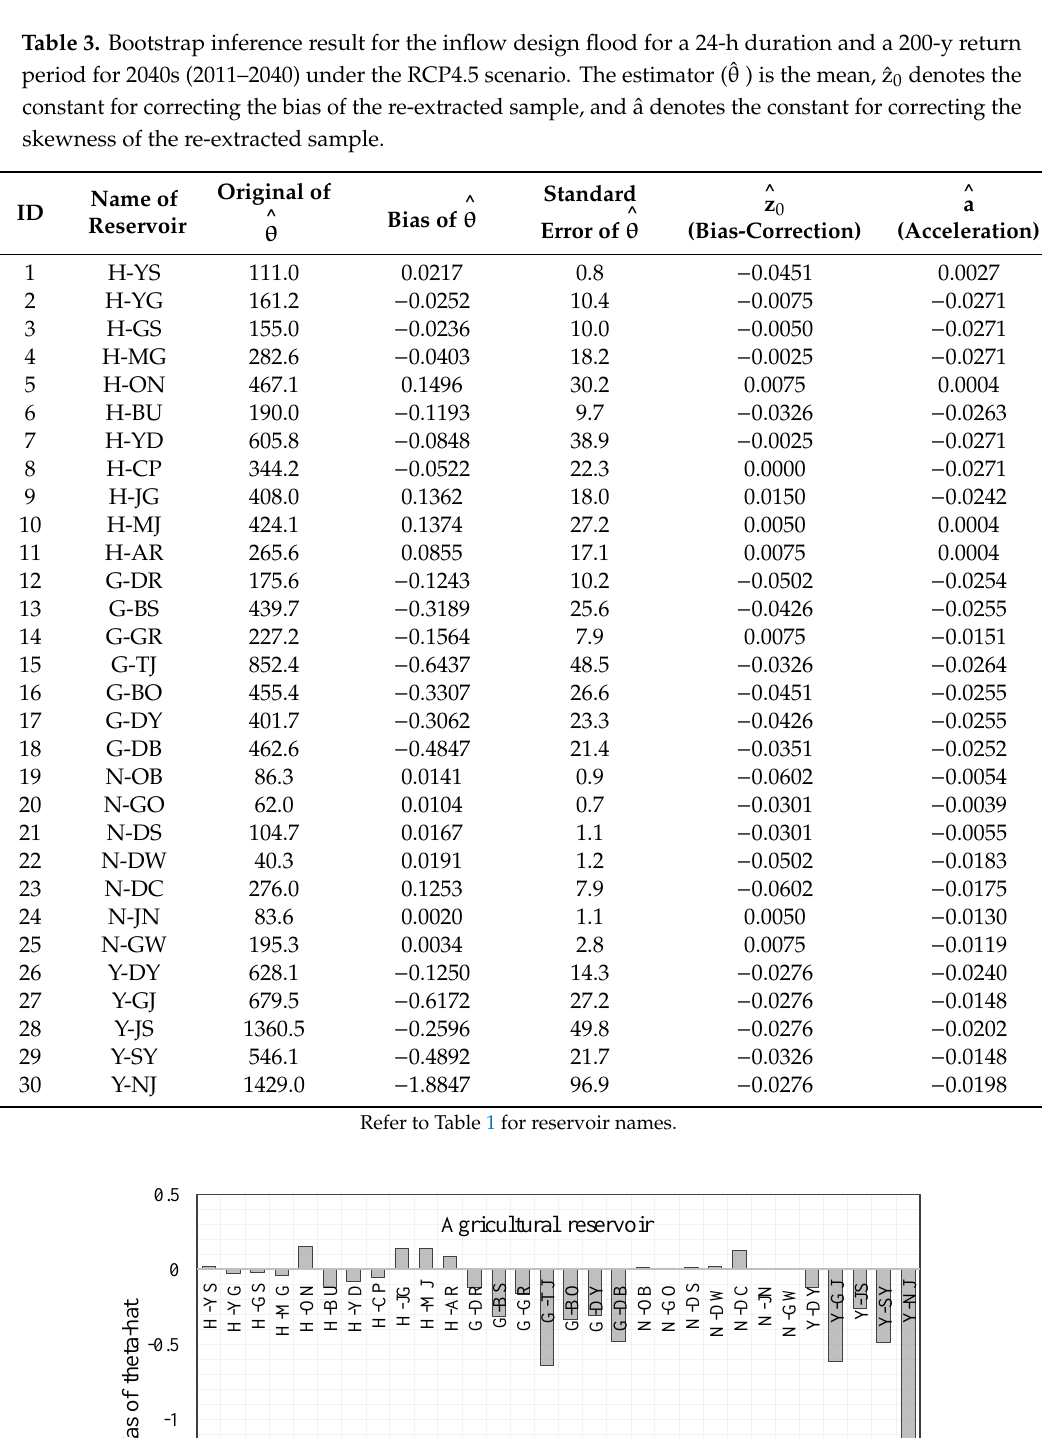
Figure 9. Standard error of θ̂ for a 24-h duration and a 200-y return period for 2040s under the RCP4.5 scenario for 30 agricultural reservoir watersheds. The estimator ( θ̂ ) is the mean. Refer to Table 1 for reservoir names. Figure 10 presents the bootstrap histogram of the inflow design flood for a 24-h duration and a 200-y return period during S1 (2011–2040) under the RCP4.5 scenario. Han River-Onam (H-ON), Geum River-Boksim (G-BO), Geum River-Dongbu (G-DB), and Yeongsan River-Damyang (Y-DY) reservoirs were selected as representatives. It can be seen that the distribution of the four reservoirs was not completely symmetrical, so the estimation of the confidence interval with the BC a percentile method was necessary.